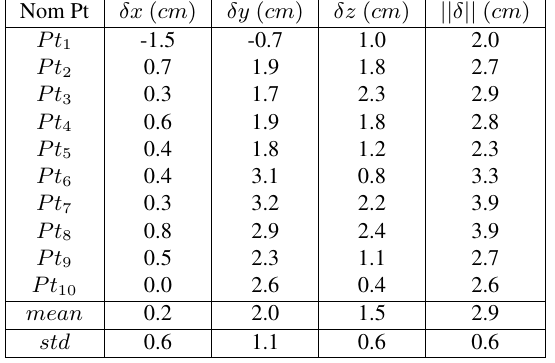
Table 1: Residuals on check points for pseudo-materialization method